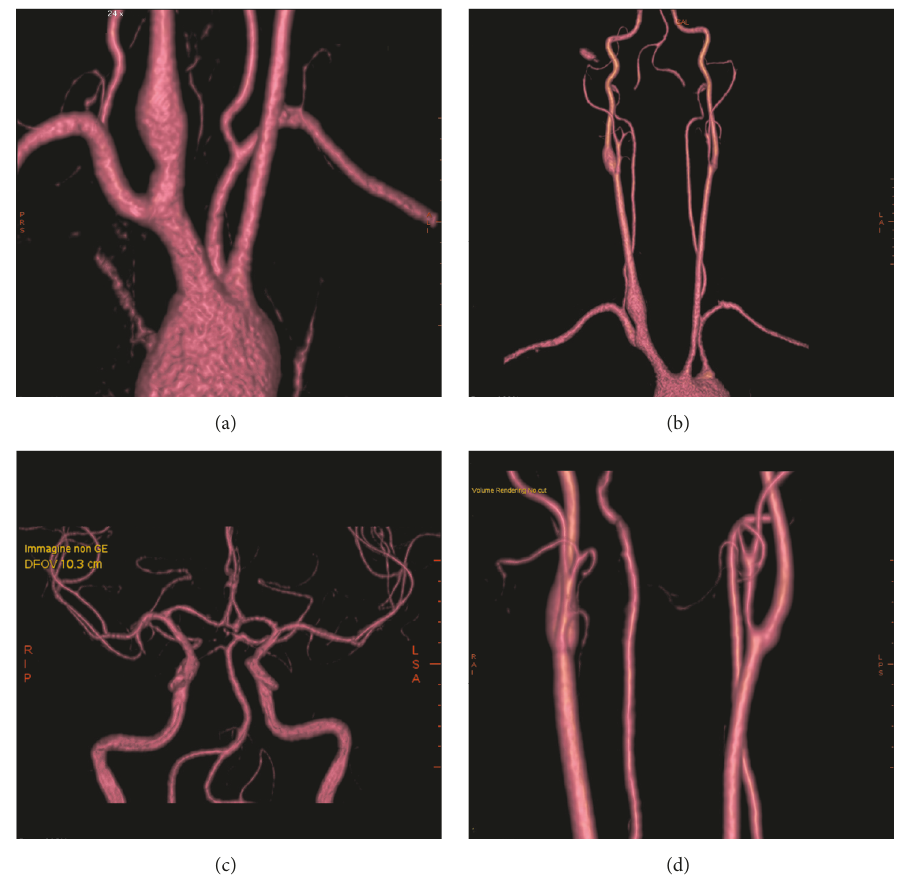
Figure 2: Volume-rendered reconstructions from Magnetic Resonance Angiography examination showing diffuse narrowing of the left subclavian artery (a) and common carotid arteries bilaterally (b). Normal caliber was found for intracranial arteries